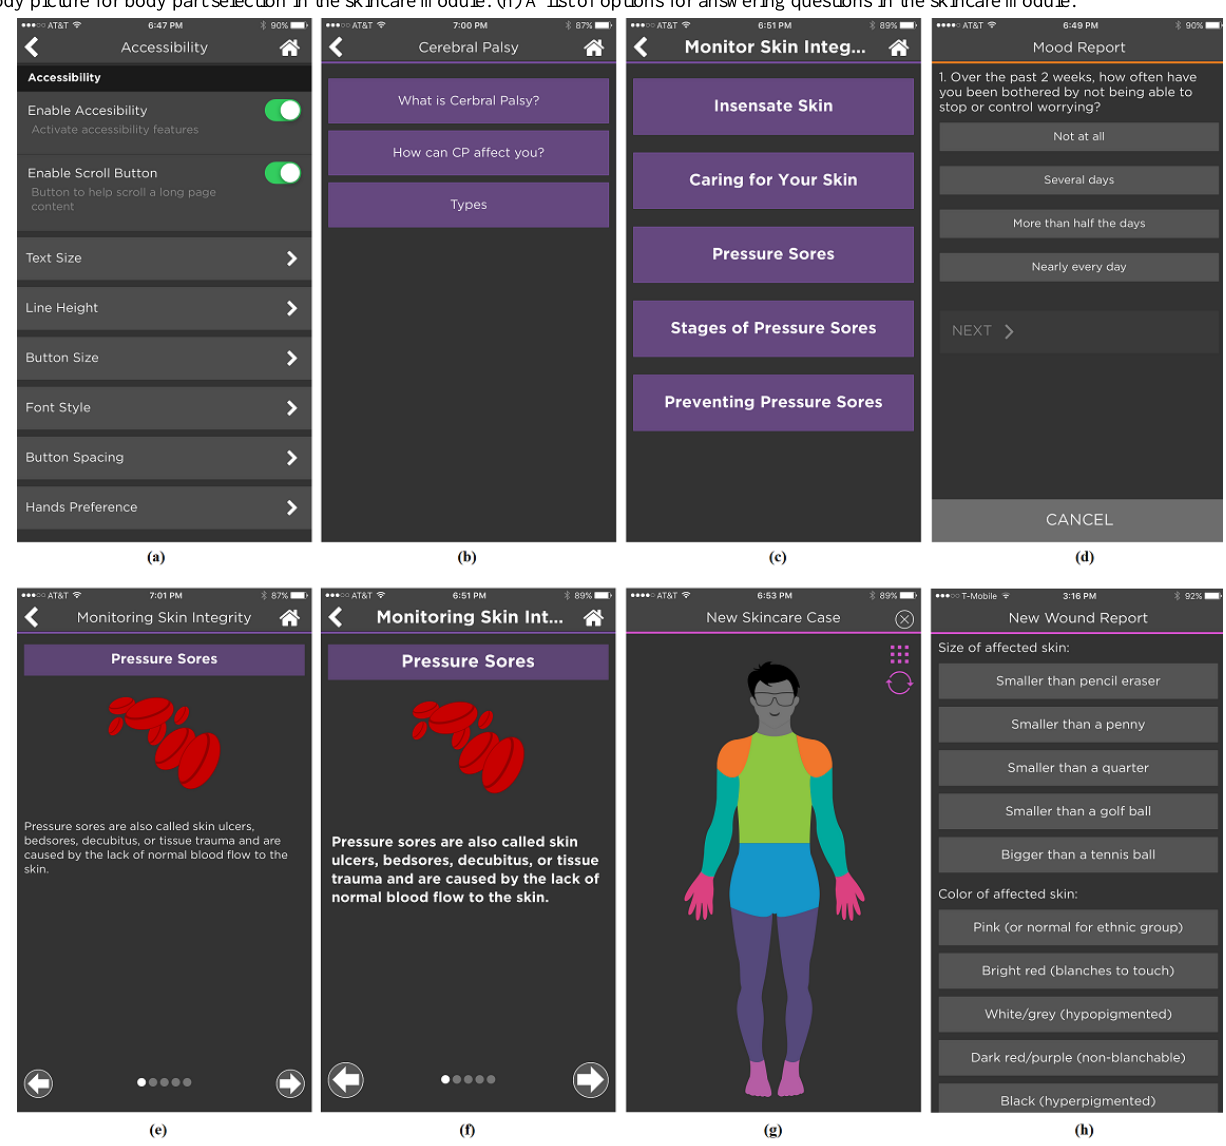
Figure 2. Accessibility features in the iMHere 2.0 client app. (a) List of customizable accessibility features. (b) A page in the education module without accessibility features. (c) A page in the education module with accessibility features. (d) One self-assessment question in the mood module with large button spacing. (e) A page in the education module with default settings. (f) A page in the education module with accessibility features. (g) A human body picture for body part selection in the skincare module. (h) A list of options for answering questions in the skincare